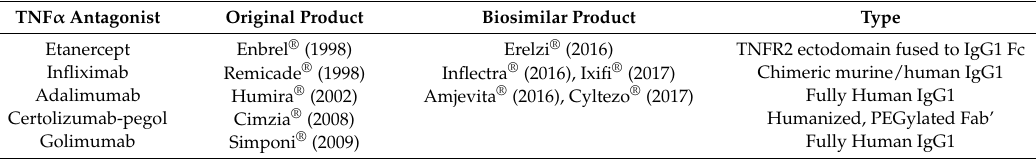
Table 1. FDA-approved TNF α